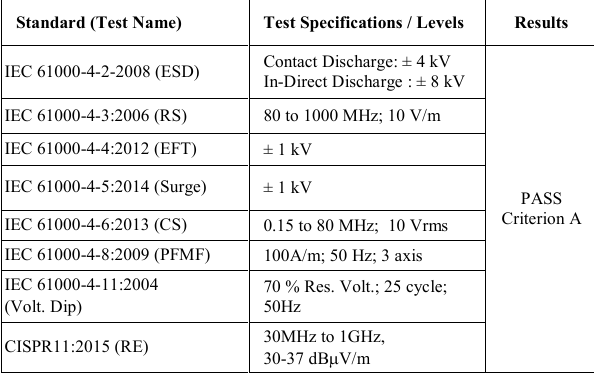
Fig. 16: Field Simulator & Control cubicle